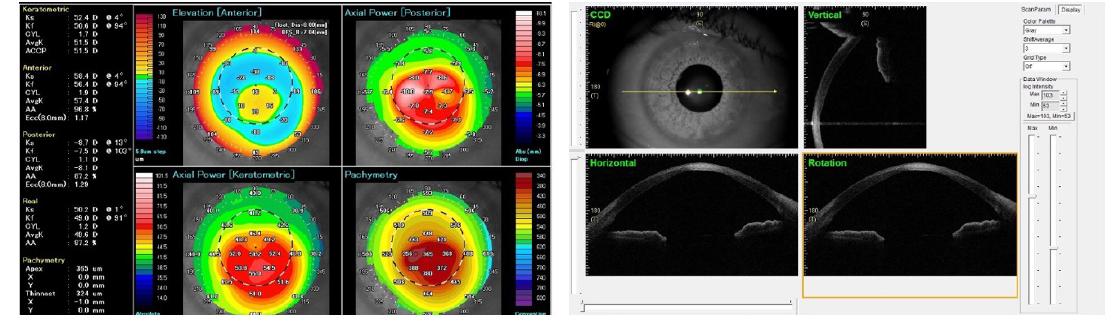
Figure 2. Representative case of a patient with keratoconus in which the two classifications were not consistent (the Sandali score higher than the Asmler–Krumeich one). The disease was classified as stage I according to the Amsler–Krumeich classification while as stage 4 according to the Sandali classification.